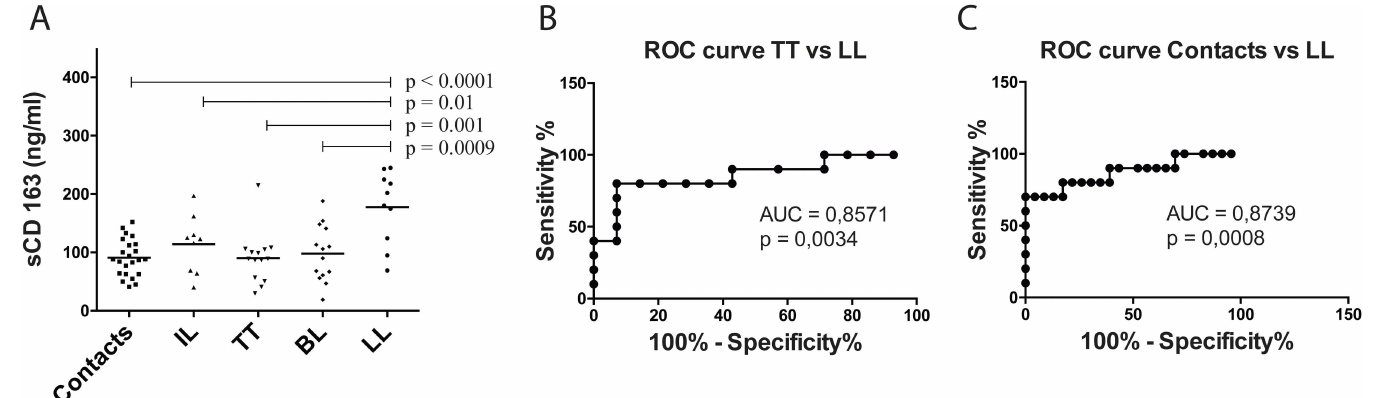
Fig 1. sCD163is elevated in the serum of lepromatous leprosy patients. (A) Sera of leprosypatients with variousclinical presentations were collected and sCD163concentrations measuredby ELISA. Householdcontacts without symptoms or signs of leprosy(Contacts) were used as a control group. The mean ± SD sCD163 levels in patients with indeterminate leprosy(IL) (n = 9; 114 ± 49,57 ng/mL), true tuberculoid leprosy (TT) (n = 14; 90,29 ± 44,06 ng/mL), borderlineleprosy (BL) (n = 14; 97,71 ± 47,97 ng/mL) and lepromatous leprosy(LL) (n = 10; 177,6 ± 62,18 ng/mL), as well as contacts (n = 23; 90,78 ± 31,55 ng/mL) were comparedby Mann-Whitney test. ROC curves comparing sCD163concentrations from TT versus LL (B) and Contacts versus LL patients (C) were constructed and are shown.